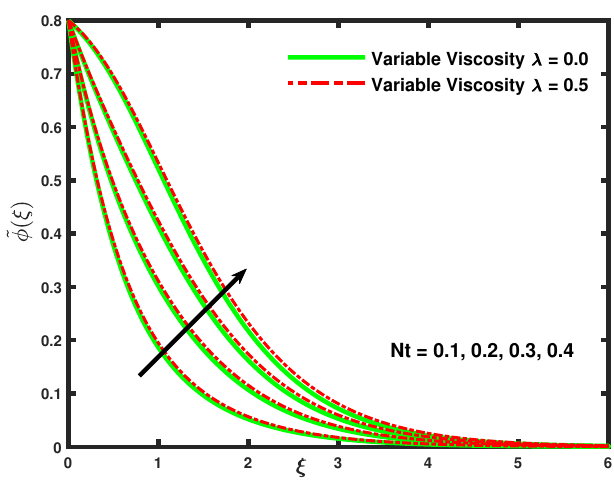
Figure 10. The influence of the thermophoresis parameter ( Nt ) on the Concentration profile.